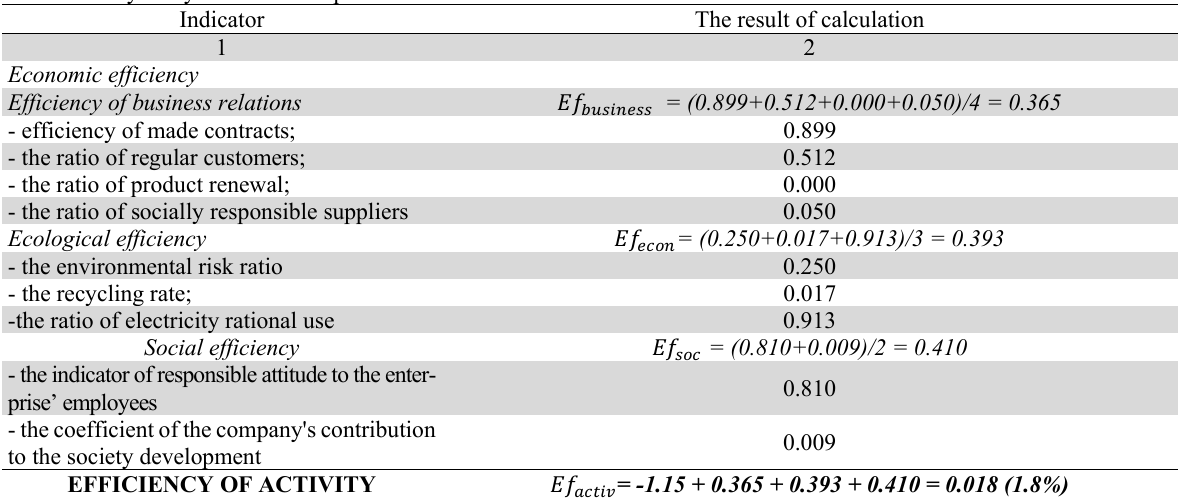
The efficiency analysis of the